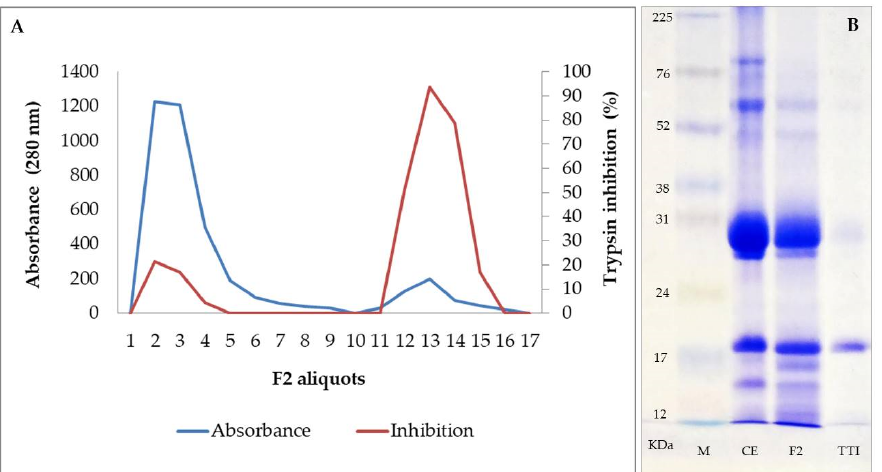
Figure 2. Characterization of the trypsin inhibitor isolated from tamarind seeds. ( A ) Trypsin-Sepharose CNBr 4B affinity chromatography of fraction 2 (F2). A measure of 5 mL of F2 obtained from the crude protein extract of tamarind seeds were applied. The blue line indicates the absorbance at 280 nm of the 3 mL aliquots eluted with 5 mM HCl at a flow rate of 0.5 mL/min; the red line indicates the percentage of antitrypsin activity of the proteins in 100 μ L of each eluted aliquot, evaluated using 1.25 mM N ‐ benzoyl ‐ DL ‐ arginine ‐ p ‐ nitroanilide (BApNA) as substrate. ( B ) 12.5% SDS ‐ PAGE showing the electrophoretic profiles of the crude extract obtained from tamarind seeds, of the F2 and of the isolated inhibitor. CE: crude extract; F2: fraction 2 obtained by fractionation with 30–60% of ammonium sulfate; M: marker (GERPN756E, Amersham™ ECL™ Rainbow™ Marker ‐ Full range); TTI: trypsin inhibitor isolated from tamarind seeds.